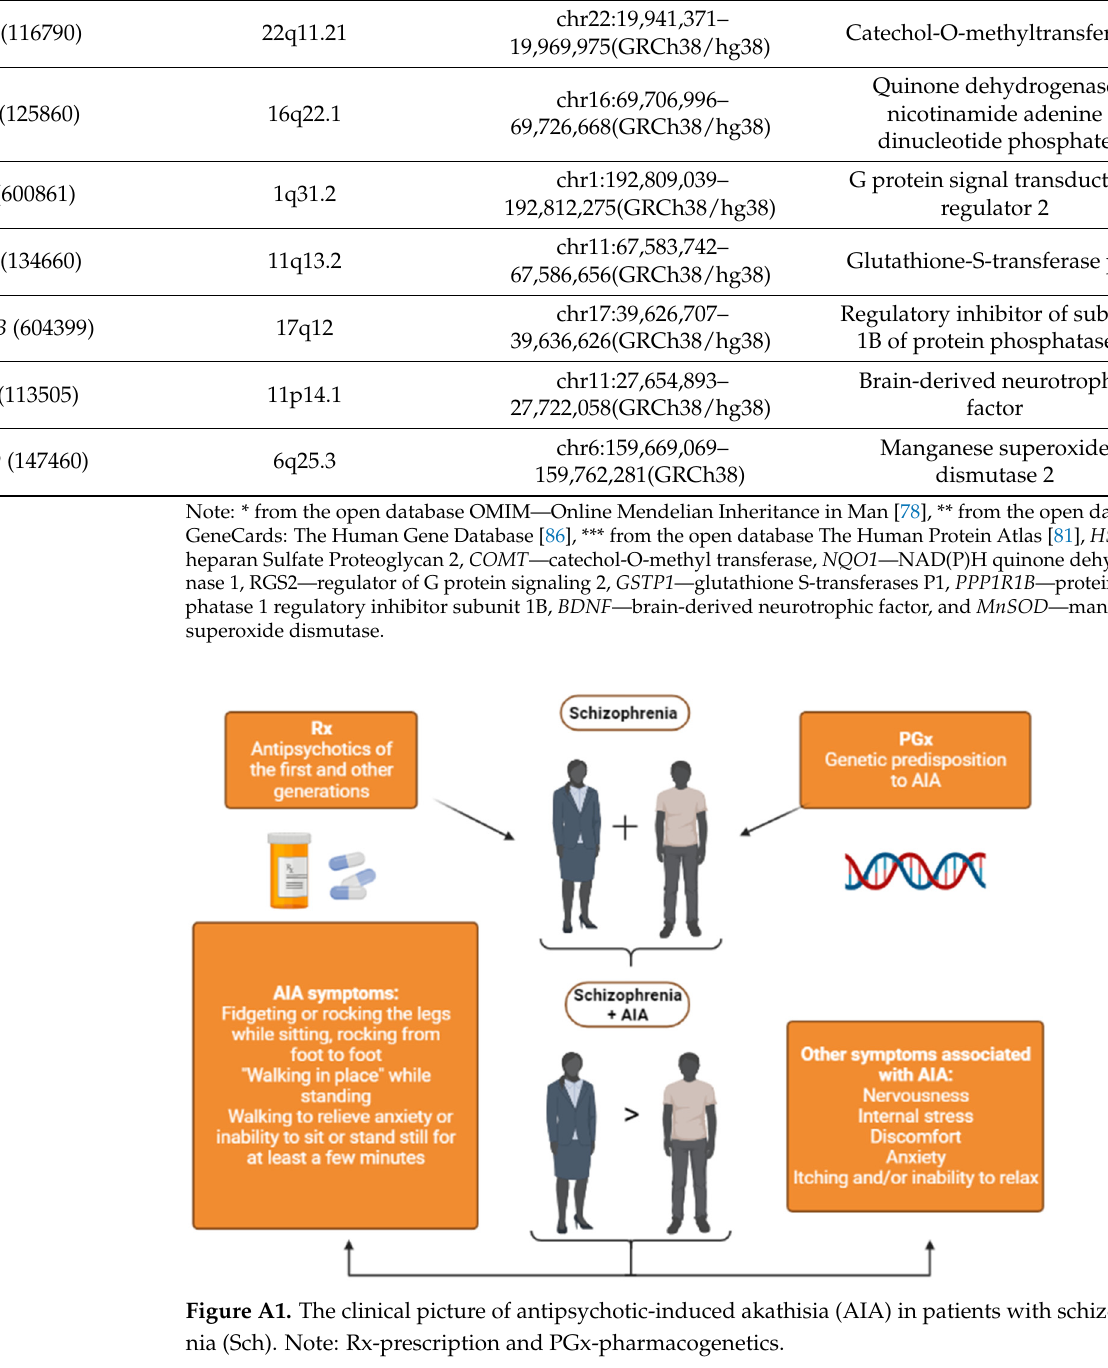
Figure A2. Antipsychotic metabolism phases [49].